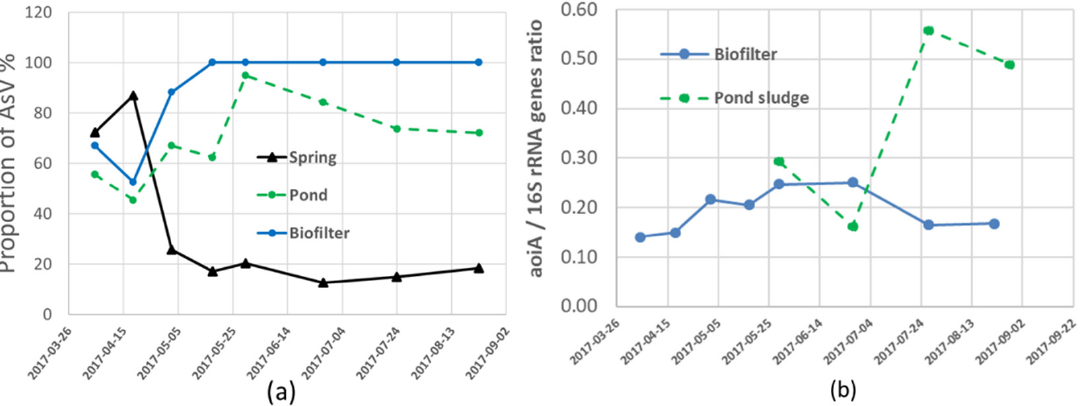
Figure 4. Dissolved As(V) proportion ( a ), and aio A/16S rRNA genes ratio ( b ) during the 2017 monitoring period.